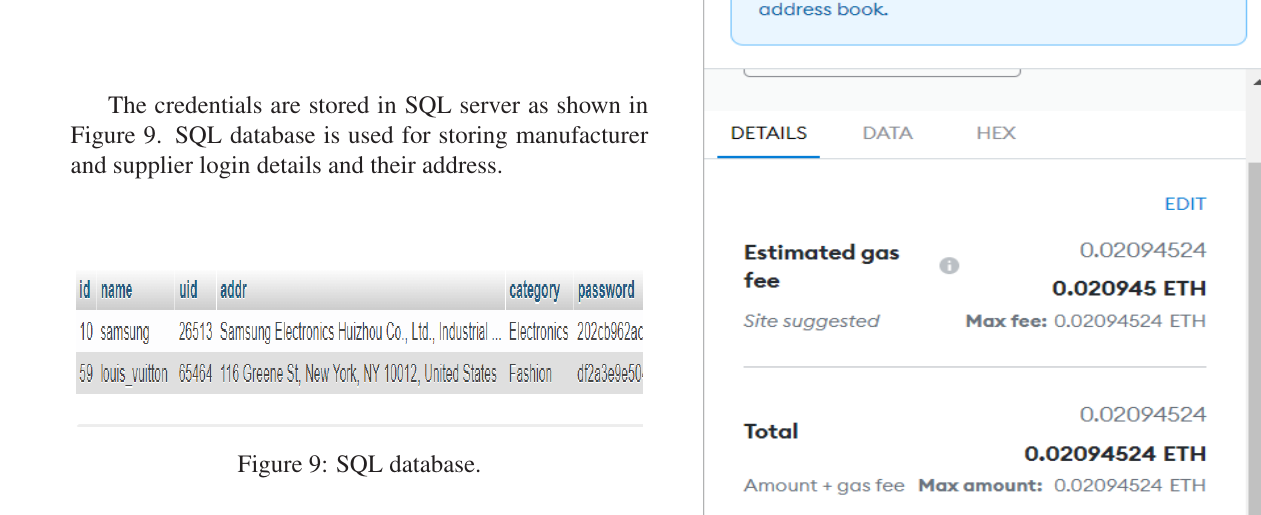
Figure 9: SQL database.